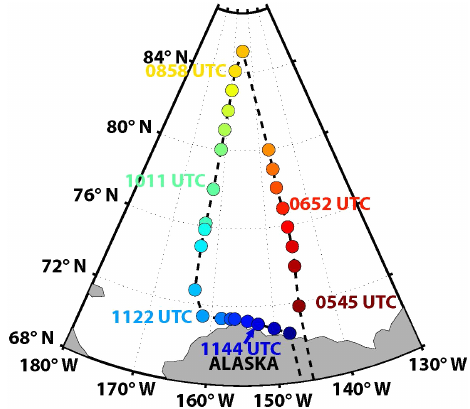
Figure 3. Global Hawk Arctic flight track showing Alaska coast- line. The dropsonde locations on 10 March 2011 are indicated by colored circles, and times (UTC) associated with certain dropson- des are indicated using the corresponding